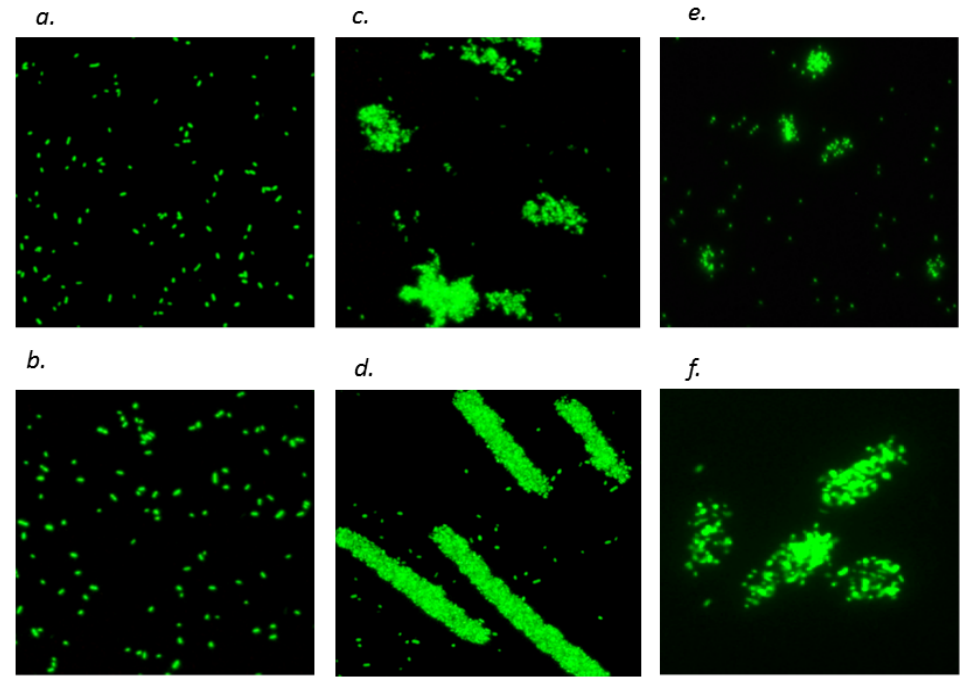
Figure 4. Aggregation of Escherichia coli (strain 25922) cell in the presence of condensed tannins (CT) of purple prairie clover (PPC; Dalea purpurea Vent.) and sainfoin (SF; Onobrychis viciifolia ). a and b , bacterial suspensions prepared from culture pre-incubated with 0 and 10 µg/mL of PPC CT for 10 h; c and d , bacterial suspensions added with 50 and 200 µg/mL of PPC CT; e and f , bacterial suspensions added with 50 and 200 µg/mL of SF CT.